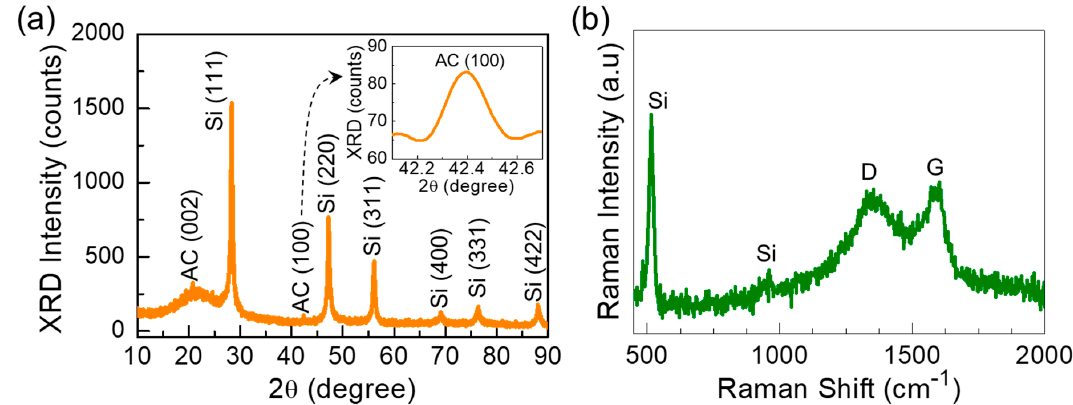
Figure 2. ( a ) XRD patterns and ( b ) Raman spectrum of the C-Si nanocomposites. The inset of ( a ) displays the zoom-in view of the AC (100) peak.